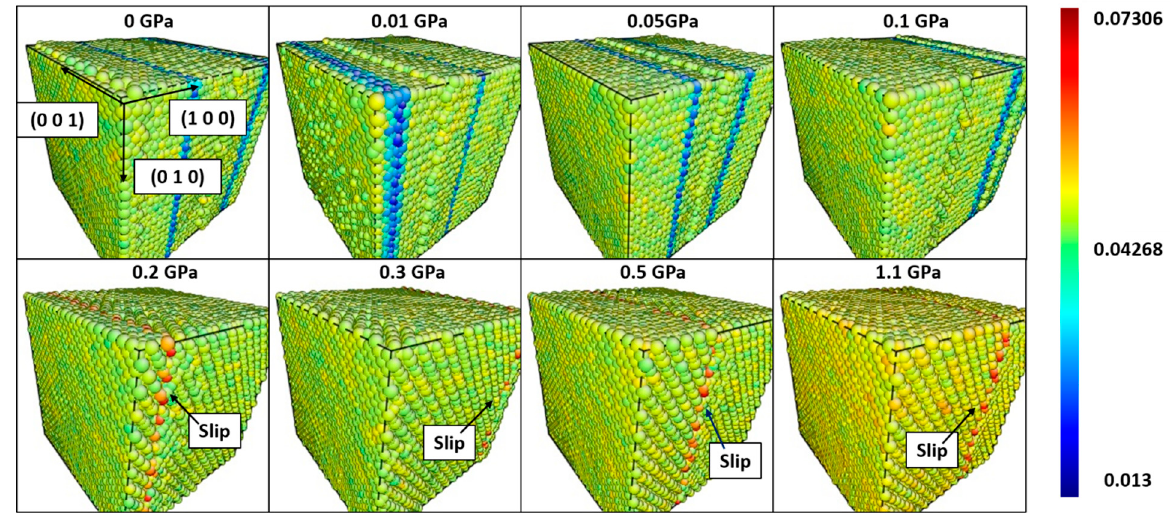
Figure 7. Atomic structure from simulation domain at 10 K under normal and shear stresses of 0–11 kbar. Atoms were colored by local von Mises shear strain invariant.